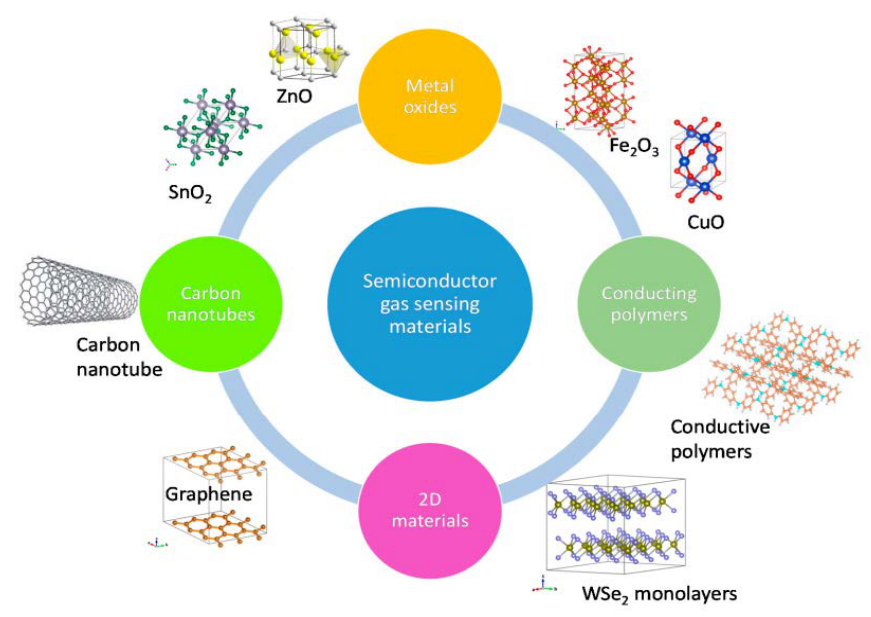
Figure 1. Semiconductor gas-sensing materials. Reprinted with permission from Ref. [35]. Copyright 2020, Nikolic, M.V. et al.